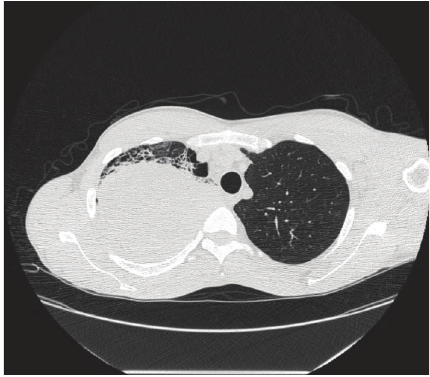
Figure 4: Chest CT scan: Rt upper lobe